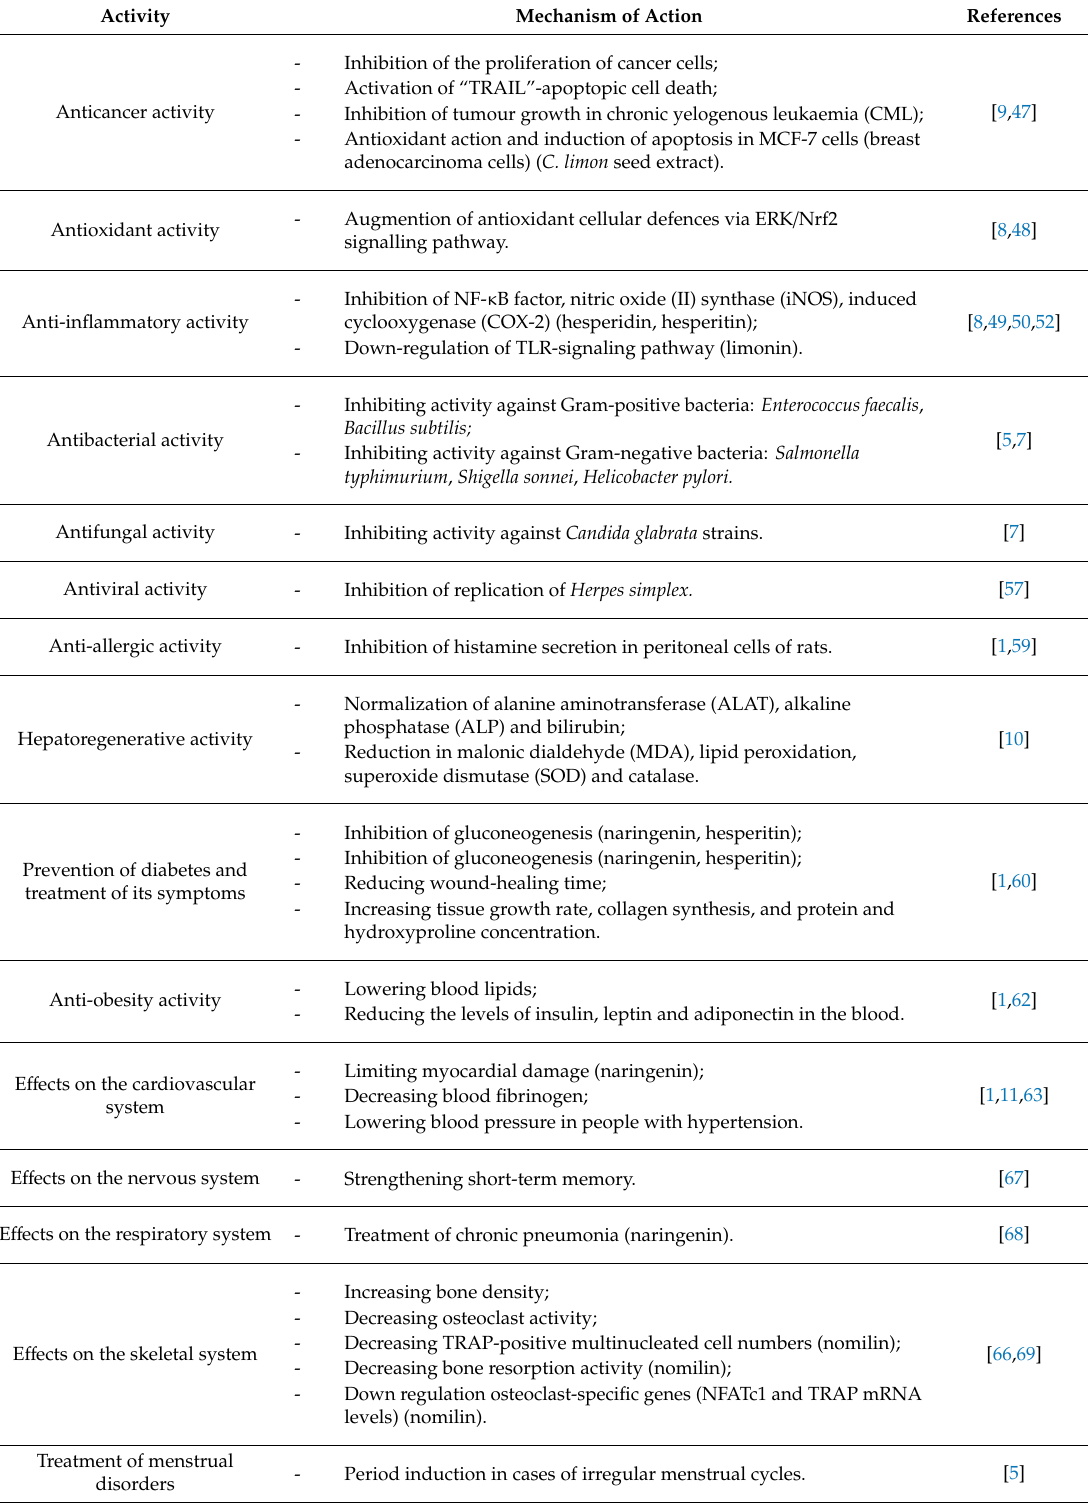
Table 7. Biological activity of C. limon fruit extracts confirmed by scientific research. Activity Mechanism of